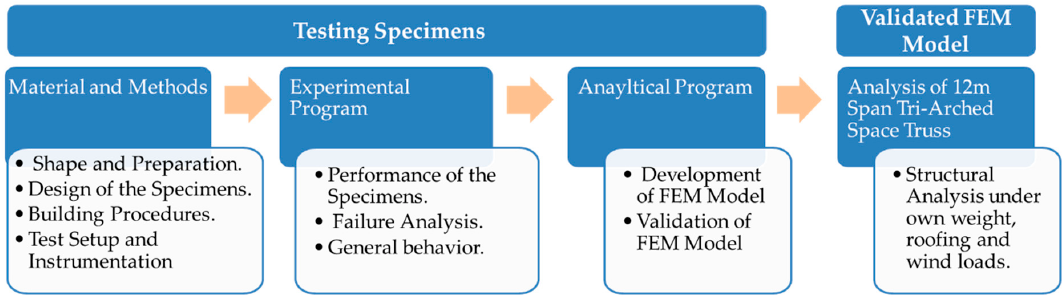
Figure 6. Flowchart of the methodology of this article.